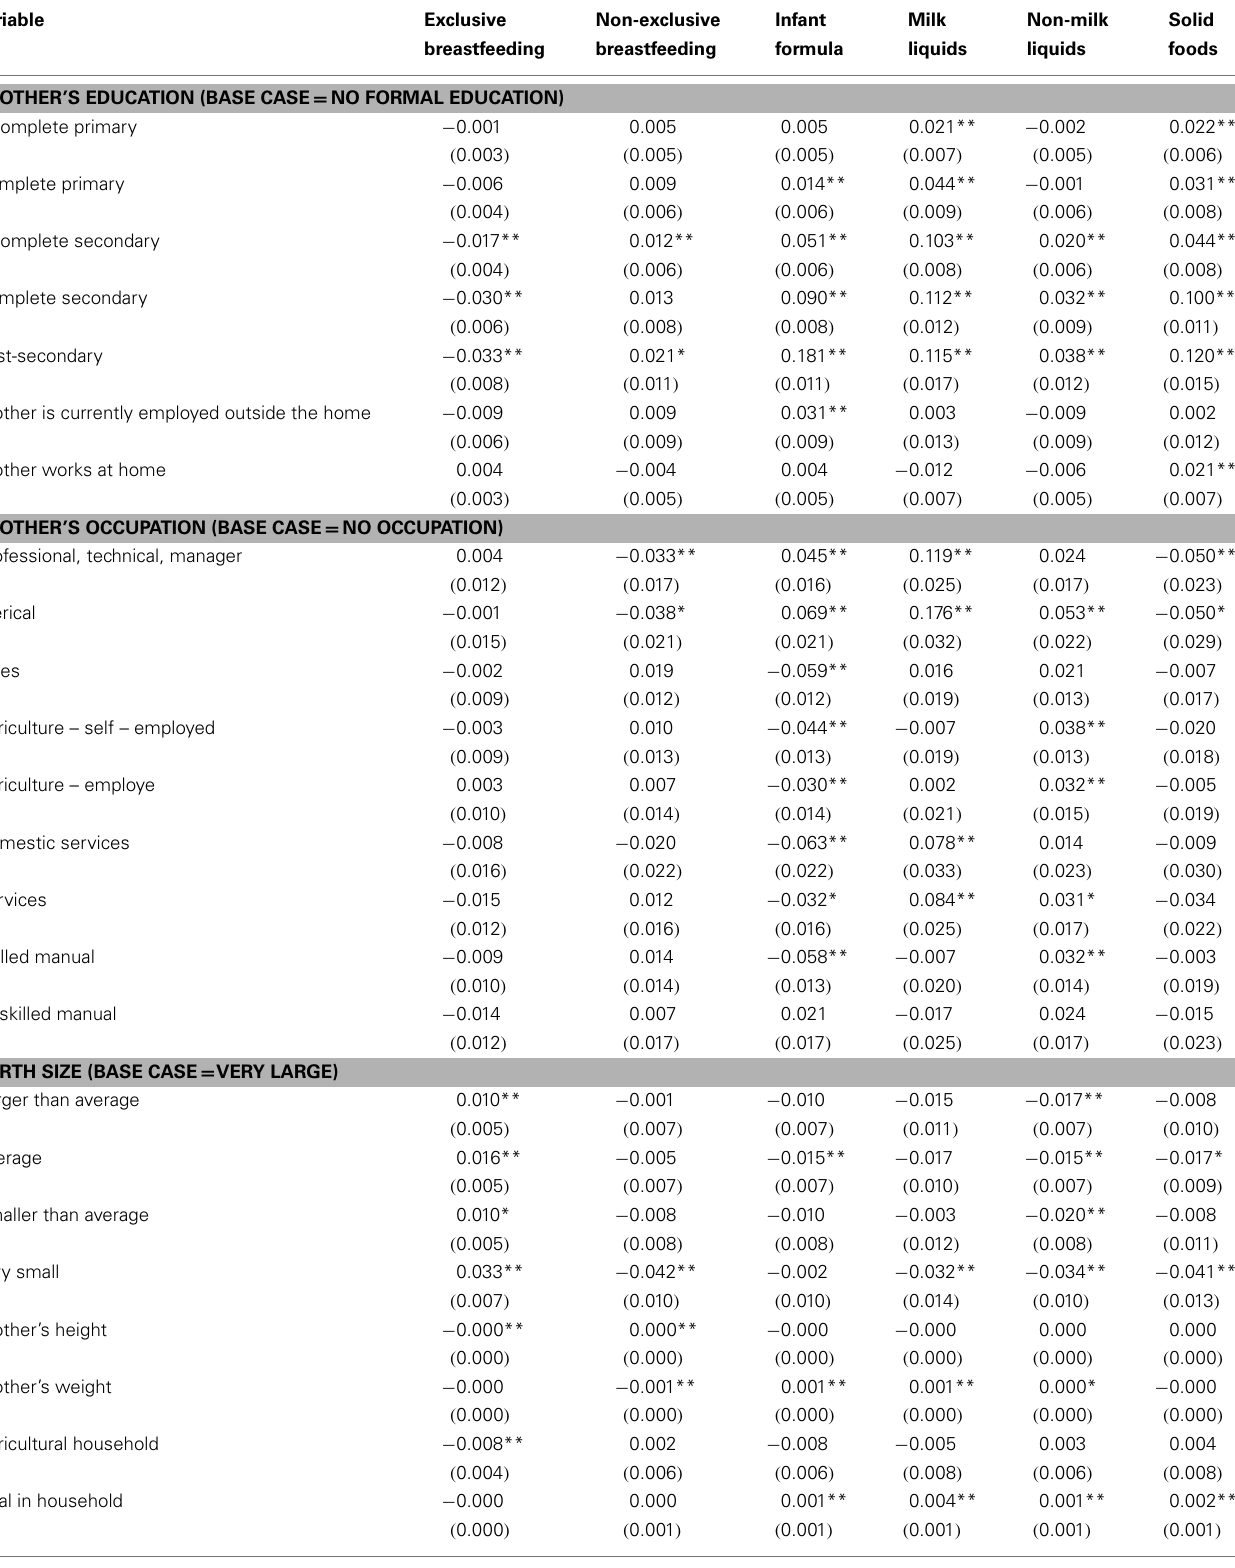
Table 3 |Associations with feeding type, age 6months to 1year